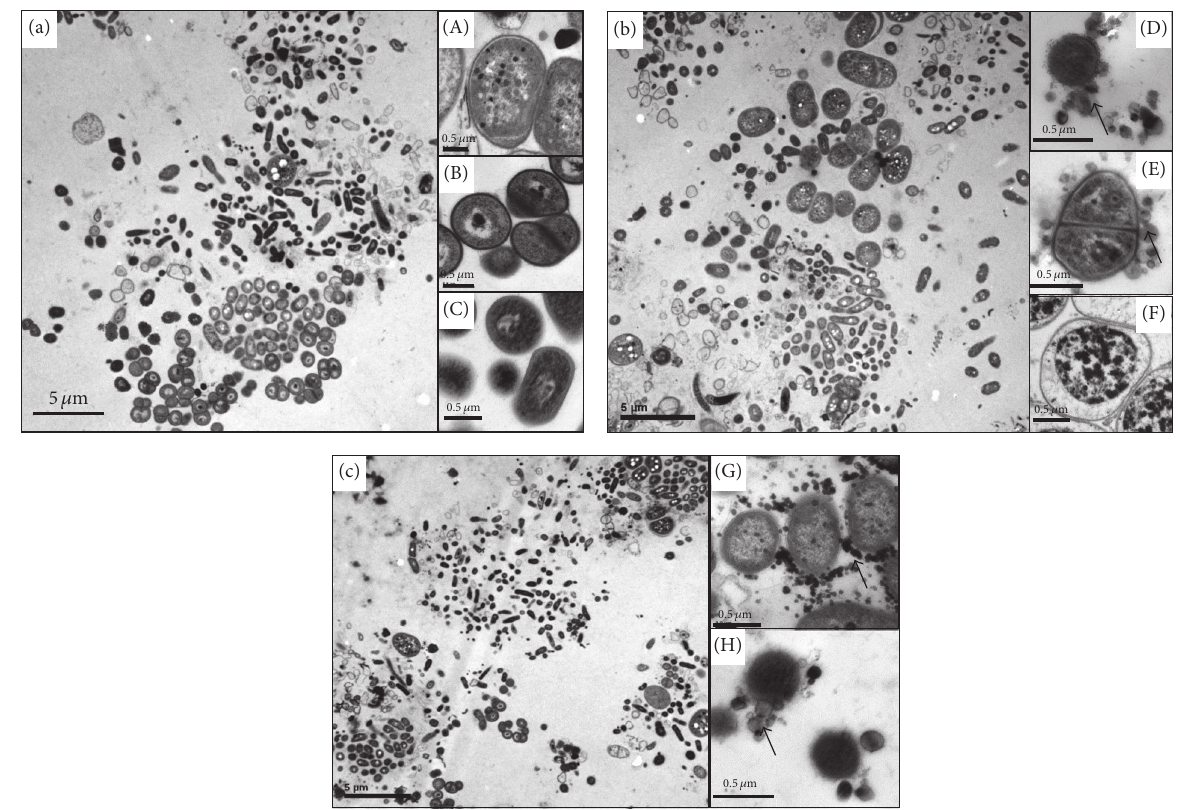
Figure 4: TEM image of sludge without (a) or with (b) the addition of 50 mg/L Si NPs after 6h. (a) Inset panels (A)–(C) and (D)–(F) show three kinds of bacteria in the sludge. In panel (c), the reaction was allowed to continue for 36 hours in the presence of Si NPs. The insets (G, H) show bacteria at the 36h time point. Arrows indicate Si